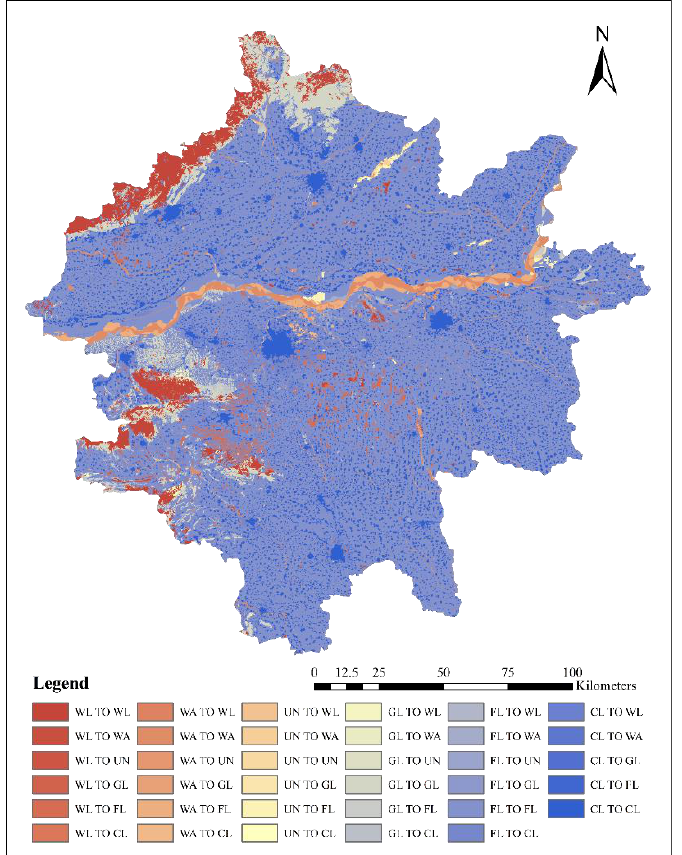
Figure 7. Spatial distribution of land use changes in Zhengzhou Metropolitan from 1980 to 2015.